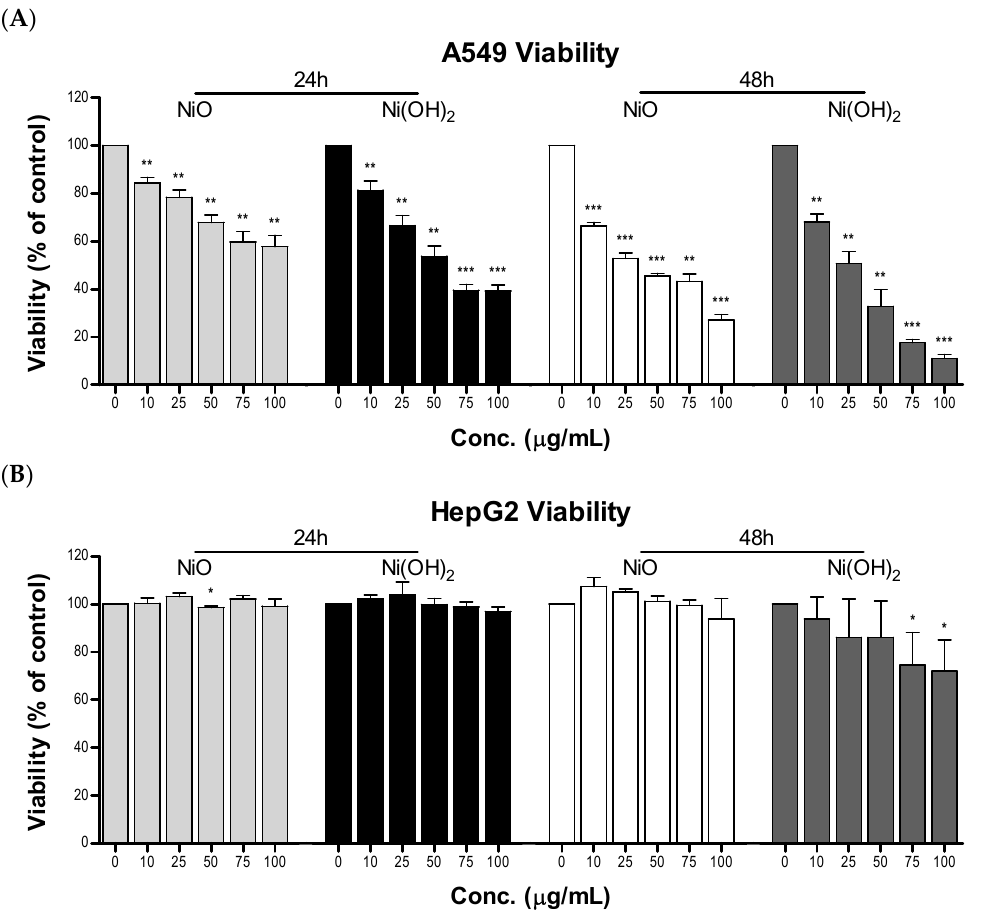
Figure 4. Viability of ( A ) A549 cells and ( B ) HepG2 cells upon exposure to various concentrations of NiO or Ni(OH) 2 for 24 and 48 h. Untreated cells were normalized to 100% viable and treated cells were the percentage of viable cells compared to the control, * p < 0.05, ** p < 0.01, *** p < 0.001 vs. control using a one-tailed, unpaired t -test. Values are expressed as the mean ± SD from three independent experiments each with three trials.